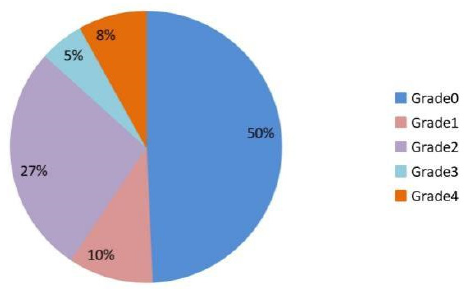
Figure 3. Grade distribution of APTOS 2019.